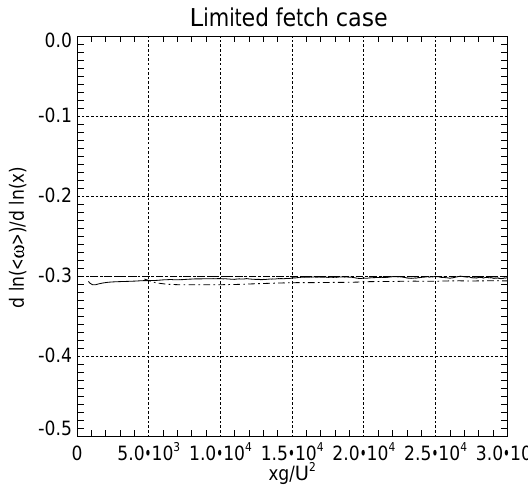
(cid:104) ω (cid:105) as the dln x Figure 17. Decimal logarithm of the angle averaged spectrum as the function of the decimal logarithm of the frequency for the wind speed U = 10ms − 1 limited fetch case – solid line. Spectrum ∼ f − 4 – dashed line; spectrum ∼ f − 5 – dash-dotted line.